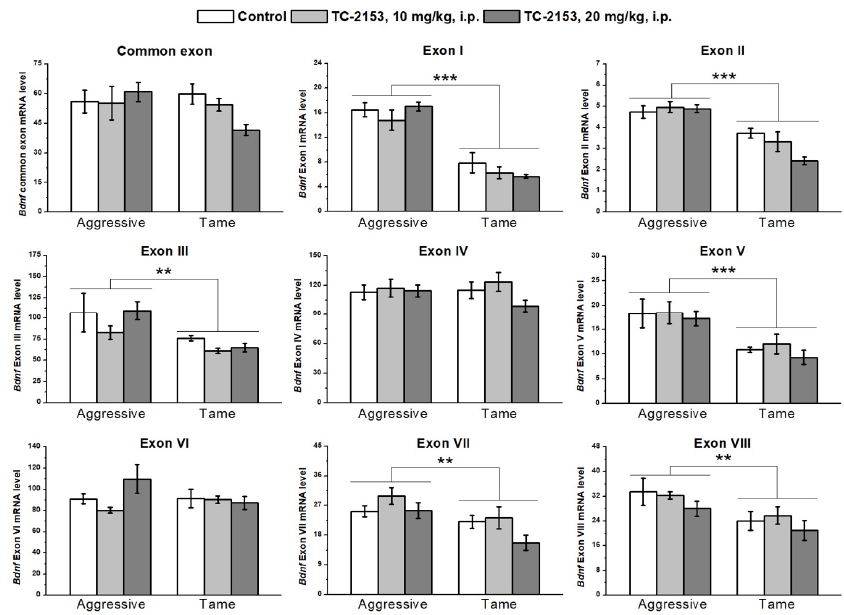
Figure 1. Effects of acute administration of vehicle (control) or TC-2153 at a dose of 10 or 20 mg/kg on mRNA levels of Bdnf (brain-derived neurotrophic factor) regulatory exons I–VIII and coding (common) exon IX in the cortex of aggressive and tame rats. The expression levels were evaluated as the number of transcript copies per 100 copies of Polr2a mRNA. ** p < 0.01 and *** p < 0.001 for the genotype effect (5–7 animals per group).